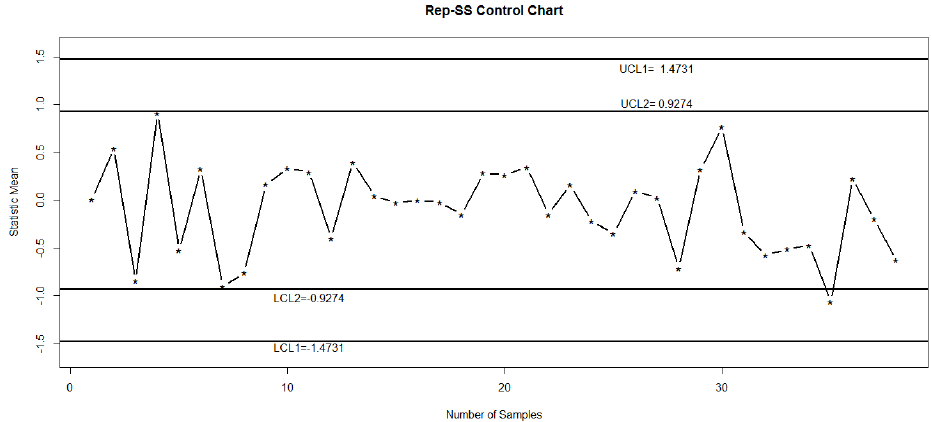
Figure 4. Control chart using repetitive sampling for simulation data: ARL 0 = 370 for i = 2 and ρ = 0.6 with n = 30 .